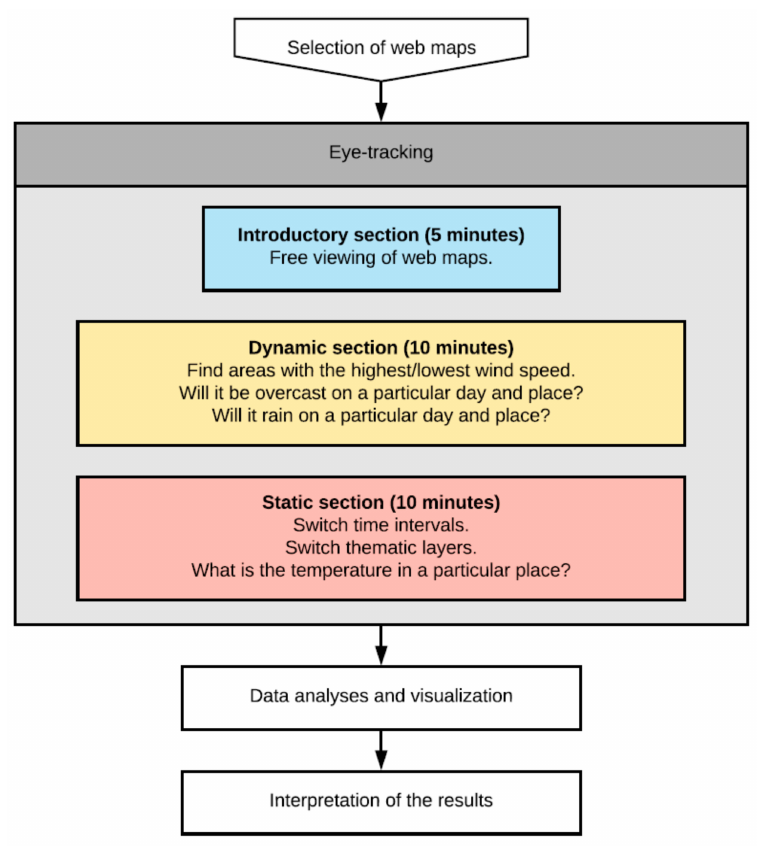
Figure 6. Map evaluation